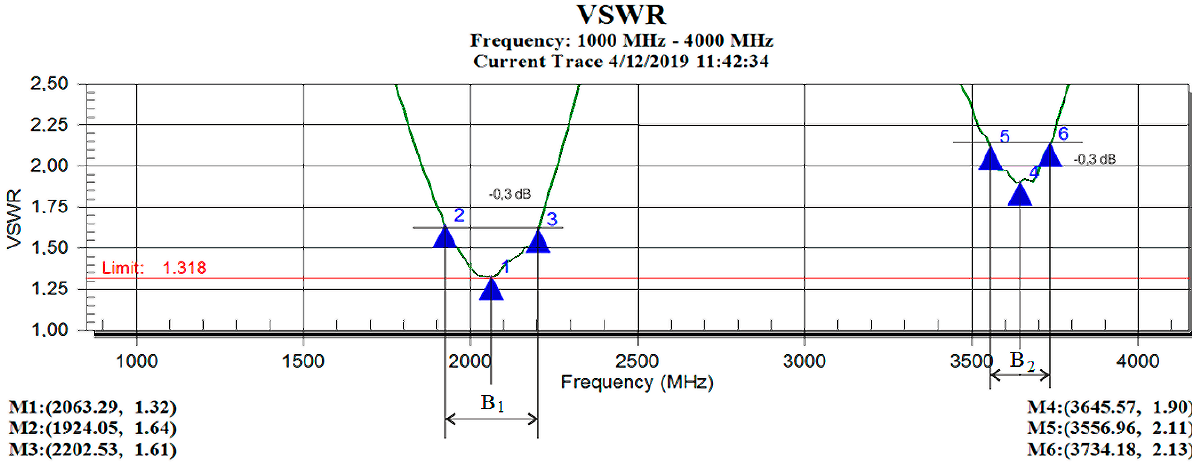
Sensors 2021 , 21 , x FOR PEER REVIEW Figure 2. VSWR antenna recording for determining the value of the resonance frequency.